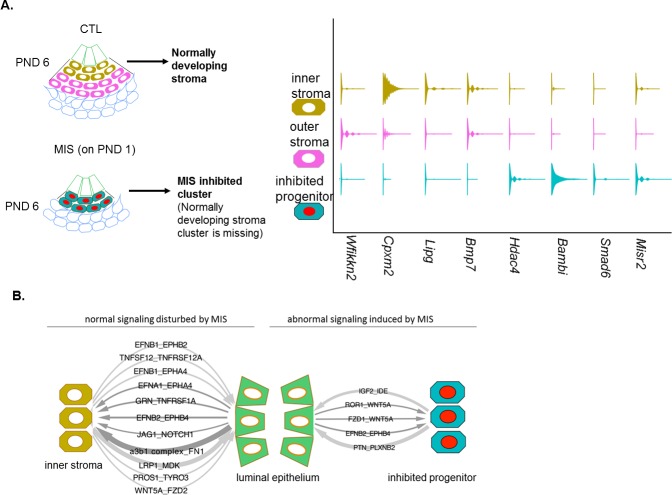
MIS treatment blocks the differentiation of a putative progenitor cell, preventing endometrial stroma formation, which indirectly dysregulates epithelial cell development.(A) When treated with MIS, a unique population of Misr2+ subluminal putative progenitor cells are retained (inhibited progenitors), while the inner and the outer endometrial stromal layers fail to develop (representative scheme on the left). Note the differential expression pattern of stromal markers in the violin plots of the control and the MIS-treated uterine cells. See Figure 3 and Figure 4—figure supplements 1–3 for validation of these markers on tissue sections. (B) Diagrams of the unique receptor-ligand pairs present 1) between luminal epithelial cells and inner stromal cells (which are absent in MIS-treated uteri) (left), and 2) between the epithelial cells and the inhibited progenitor cells, (which are only present in the MIS-treated group).10.7554/eLife.46349.022Figure 4—source data 1.Cell phone DB analysis.First worksheet shows the filtered gene names depending on clusters (shown in the figures). Second worksheet includes all the gene names. Related to Figure 4B, Figure 4—figure supplement 4.10.7554/eLife.46349.023Figure 4—source data 2.Differentially expressed genes (MIS vs Control) in the luminal epithelium of the developing rat uteri.Related to Figure 4—figure supplement 4F.